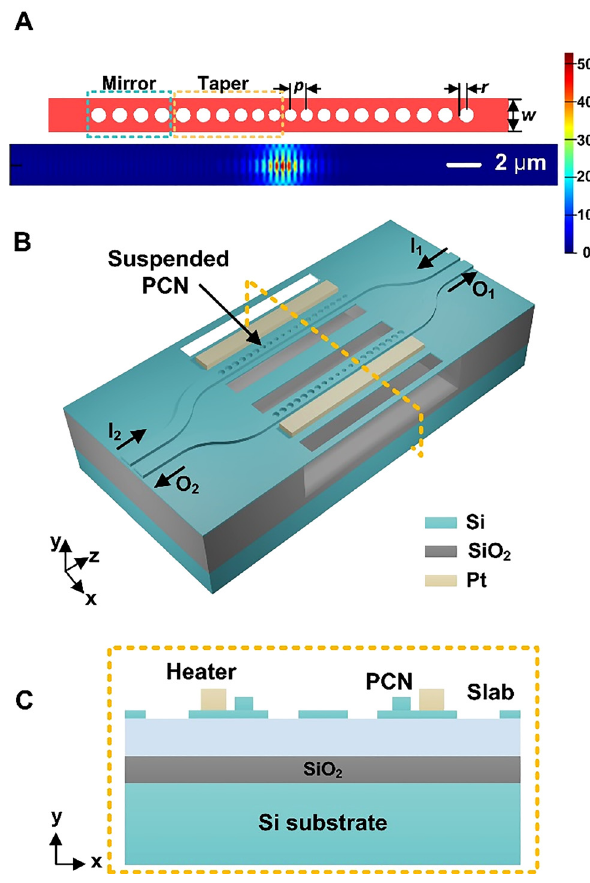
Figure 2: Schematic diagrams of the suspended photonic crystal nanobeam (PCN) – based Mach – Zehnder interferometer (MZI) switch. (A) Structure and simulated optical field distribution of the PCN. (B) Device con fi guration of the switch. (C) Cross section of the con fi guration (yellow-dotted plane in